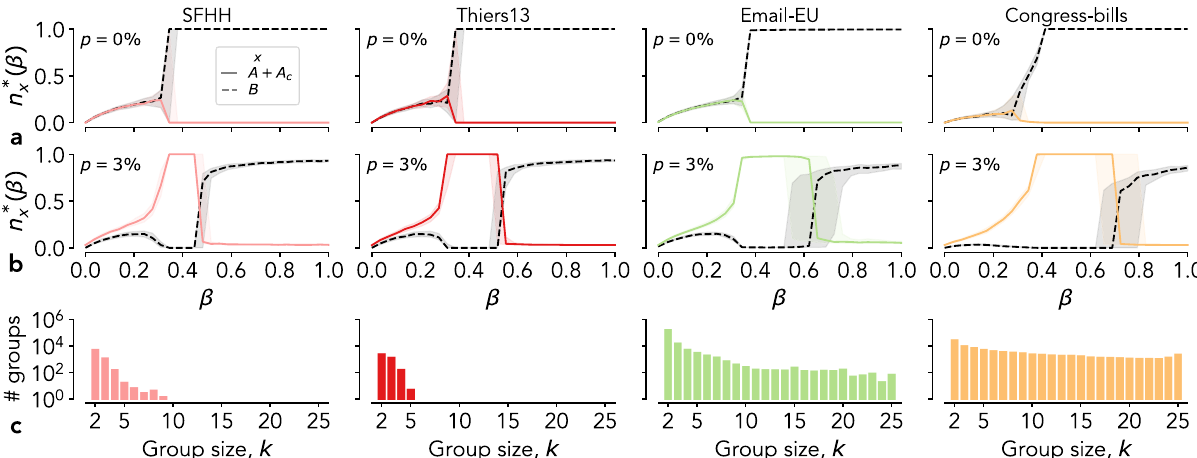
Fig. 3 Stationary state of the naming game (NG) dynamics with unanimity rule simulated on empirical higher-order structures, and histograms of the group sizes of these structures. The considered social structures correspond to empirical data sets collected in four different contexts (see Methods): a conference (SFHH), a high school (Thiers13), email communications (Email-EU) and a political congress (Congress-bills). Panels a and b correspond respectively to simulations without and with committed minorities A c supporting name A (respectively, fraction of committed p = 0 and p = 3%). In these panels, we plot the fraction of nodes supporting name x in the stationary state, n (cid:1) x ð β Þ , obtained by means of numerical simulations on each data set, as a function of the social in fl uence parameter β . Lines (continuous and dashed, respectively associated to names A + A c and B ) and shaded areas refer to the median values and values contained within the 25th and 75th percentile measured over 150 runs. The panels c shows the histograms of group sizes associated to each data set, where a group of size k represents a higher-order interaction (of order k − 1) between k